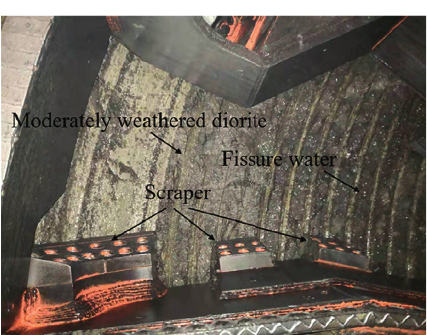
Figure 7: Excavation surface condition during field seepage measurement.